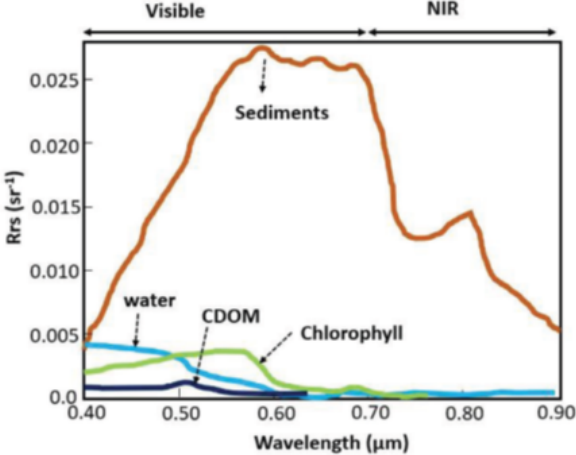
Figure 1. Spectral signatures of water with sediments (orange), clear water (blue), water with chlorophyll content (green), water with Chromophoric Dissolved Organic Matter - CDOM (black). Rrs is the reflectance registered by the sensor. Source: Hafeez et al.